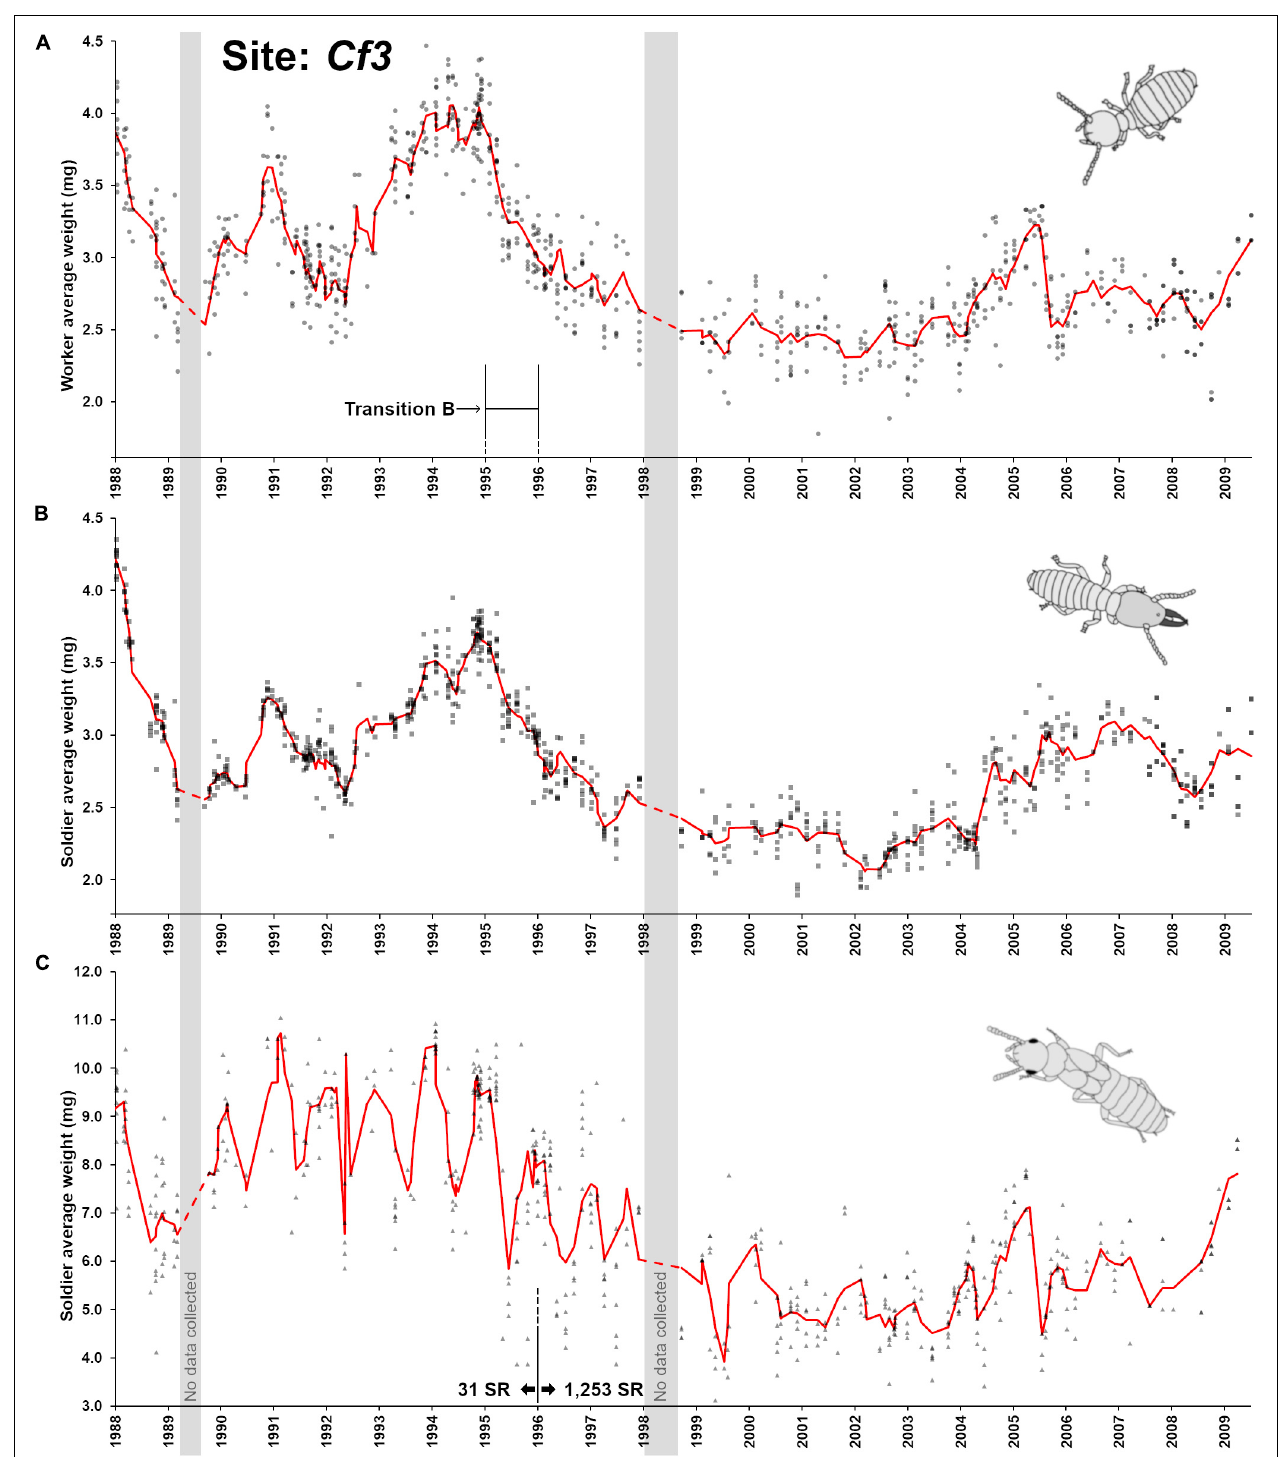
FIGURE 5 | Colony demographic changes for Coptotermes formosanus at site Cf3 . Each data point represents an average caste weight from a field trap. For the 1988–2009 demographic trends of each caste, the red line represents the rolling average function (period = 3). (A) Workers’ average weight between. (B) Soldiers’ average weight. (C) Nymphs’ average weight between. “Transition B” represents a major reproductive shift within the colony with the ongoing production of secondary reproductives ( = SR, 1,253 produced after 1995) which may have resulted in cycles of inbreeding. No clear annual demographic cycles could be found in workers and